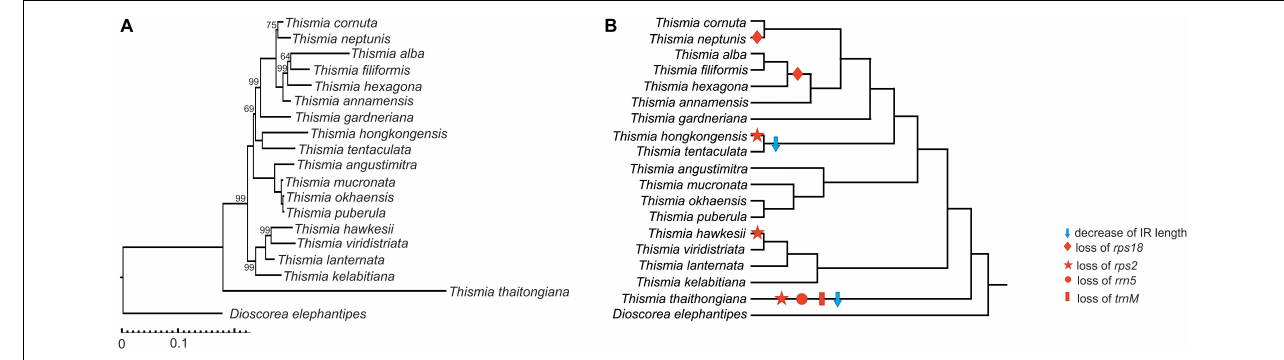
FIGURE 3 | Phylogenetic tree based on Thismia plastid genes. (A) Phylogenetic tree inferred from ML analysis of 13 plastid genes by IQ-Tree with branch lengths and bootstrap values (only values < 100 are shown). (B) The same tree showing gene losses and IR borders changes.